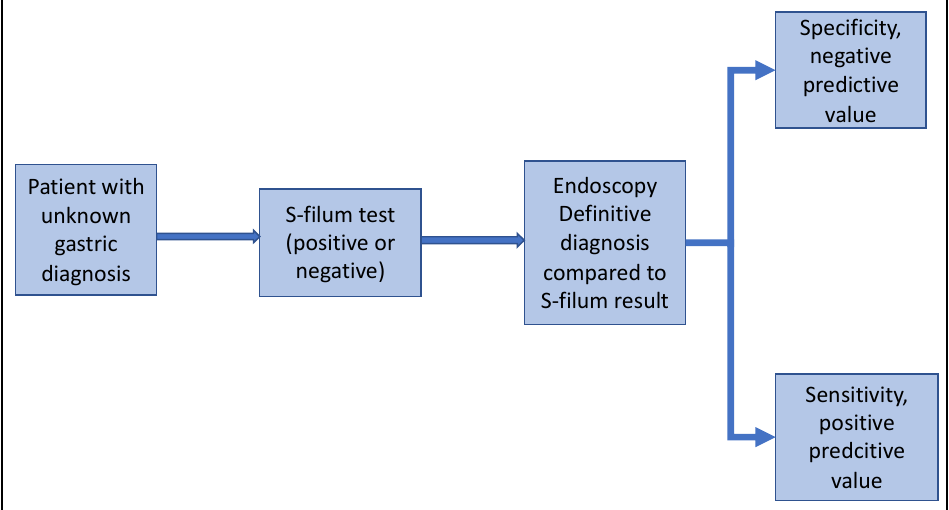
Figure 2. Summary of patient enrollment and determination of validity of the S-filum.